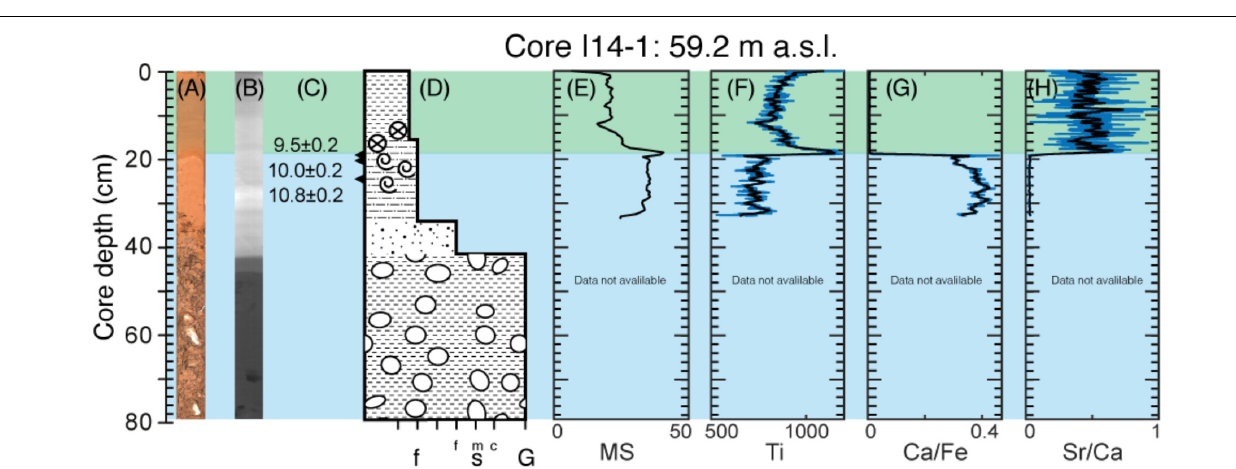
Supplementary Table S3b ). Toward the top of the lower unit, the by Elphidium clavatum, Elphidium asklundi, Buccella